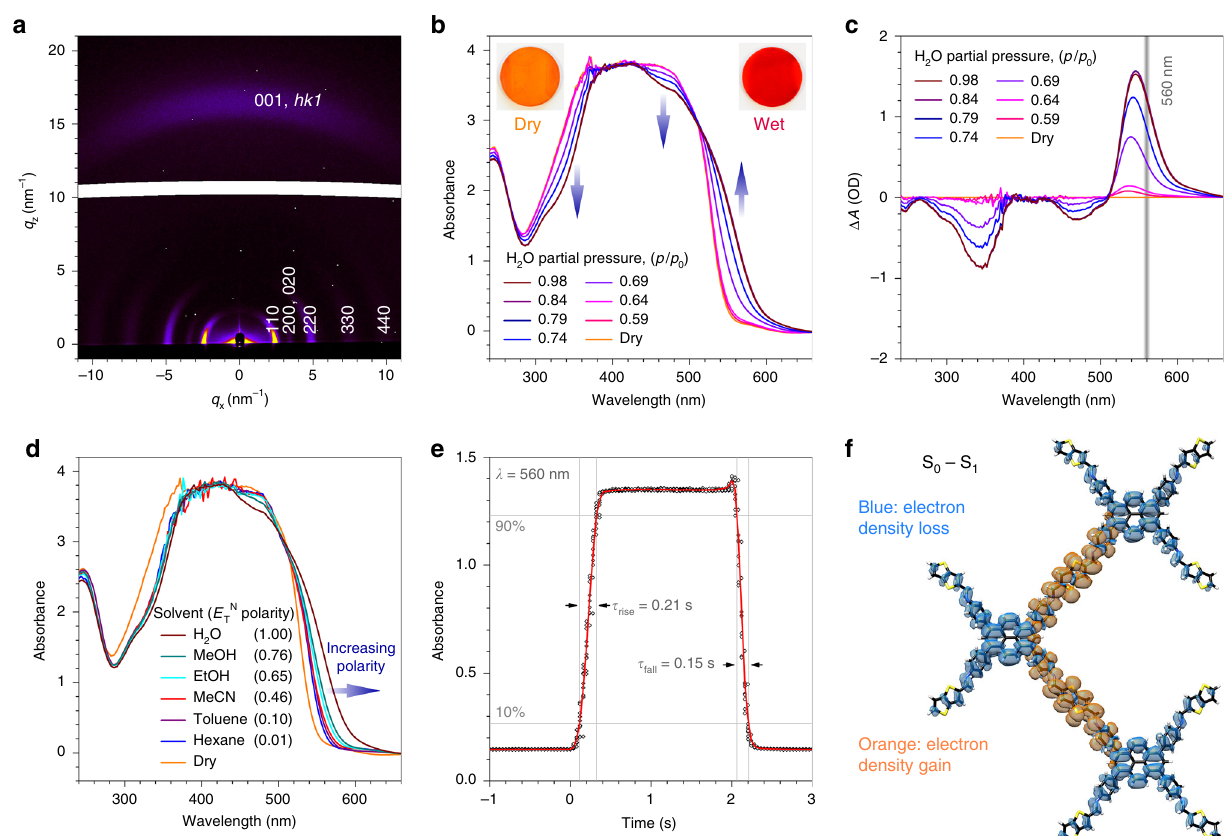
Fig. 3 Solvatochromism of Py – TT COF oriented thin fi lms. a GIWAXS pattern of a 360 nm thick Py – TT COF fi lm grown on a sapphire substrate. The intensity of hk 0 re fl ections is concentrated directly above the sample horizon, whereas the 001 and other low-index hk 1 re fl ections appear close to the substrate normal. b UV – Vis absorption spectra of the Py – TT COF fi lm recorded at different relative pressures of H 2 O in N 2 . Increasing water content causes a strong absorption increase in the 520 – 640 nm region, accompanied by a reduced absorption in the 440 – 500 nm and 280 – 380 nm regions. Insets, photographs of the COF fi lm in the dry and water-saturated states. c Corresponding plot of the humidity-induced absorbance changes, A humid − A dry , at different H 2 O relative pressures. The grey line indicates the wavelength used for the response time measurements (see below). d UV – Vis spectra of the same COF fi lm in saturated atmospheres of various solvents. The solvatochromic shift increases monotonically with increasing E T N polarity of the solvents. e Solvatochromic response of the Py – TT COF fi lm towards step changes between dry and H 2 O-saturated N 2 streams. Ten individual data sets (black dots) recorded at λ = 560 nm have been averaged (red line). The response times τ rise and τ fall are determined between the 10% and 90% thresholds. f TD-DFT calculated electron density difference upon the one-electron excitation from the ground state ( S 0 ) to the fi rst singlet excited state ( S 1 ). This transition involves a reduction of the electron density on the pyrene moieties and an electron density gain of the thienothiophene bridges, and hence possesses a pronounced charge-transfer character. Electron density isosurfaces are displayed at an isovalue of 5e −